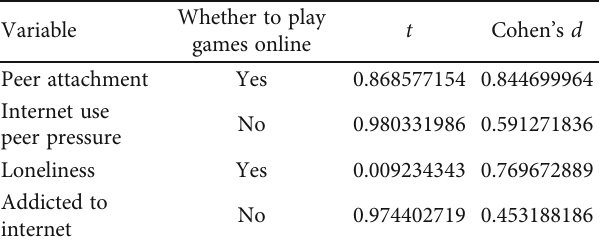
Table 2: Analysis of variability in playing games online on each